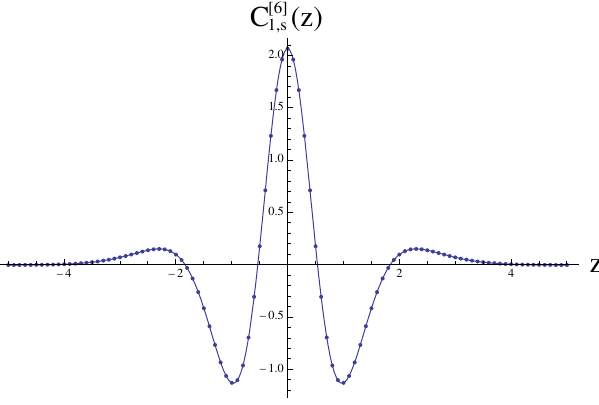
on the line (cid:1) ¼ 1 = 2 , z FIG. 12. (Color) Exact and numerical results for C ½ 6 (cid:3) 1 results are shown as a solid line, and numerical results are shown as dots.